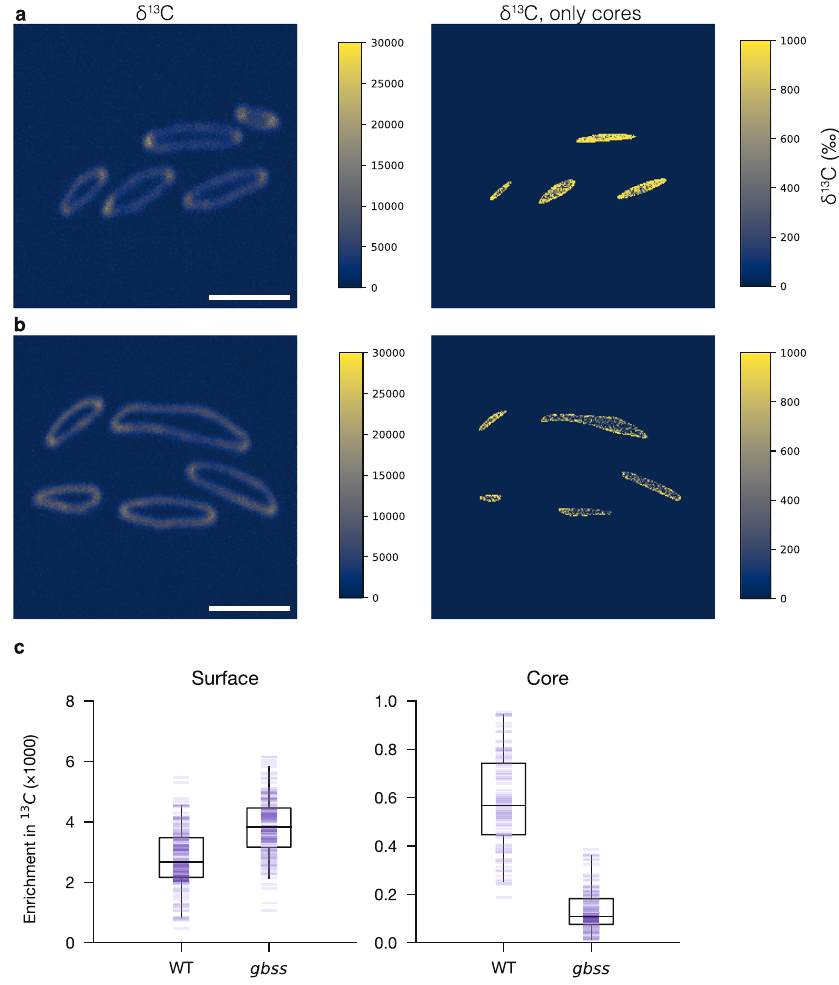
Fig. 6 GRANULE-BOUND STARCH SYNTHASE synthesizes amylose in the granule cores. Plants subjected to a normal night were labeled with a pulse of 13 CO 2 for 1 h at midday then harvested immediately for EM (not shown) and NanoSIMS imaging. Scale bars: 2 granules within wild-type chloroplasts. Manually masking the granule surfaces revealed enrichment speci fi cally in the cores (right; note different 13 C-enrichment scales). b 13 C-enrichment map of starch granules (left) and their cores (right) within chloroplasts of the gbss mutant. c Quanti fi cation of the 13 C-enrichment of granule cores and surfaces overlaid with boxplots, where the minima, maxima of the whiskers represent 2.5% and 97.5%, the bounds of box, 25% and 75%, and the center denotes 50% of the posterior. N = 259 and 269 granules for the wild type and gbss mutant, respectively, in each case from three biological